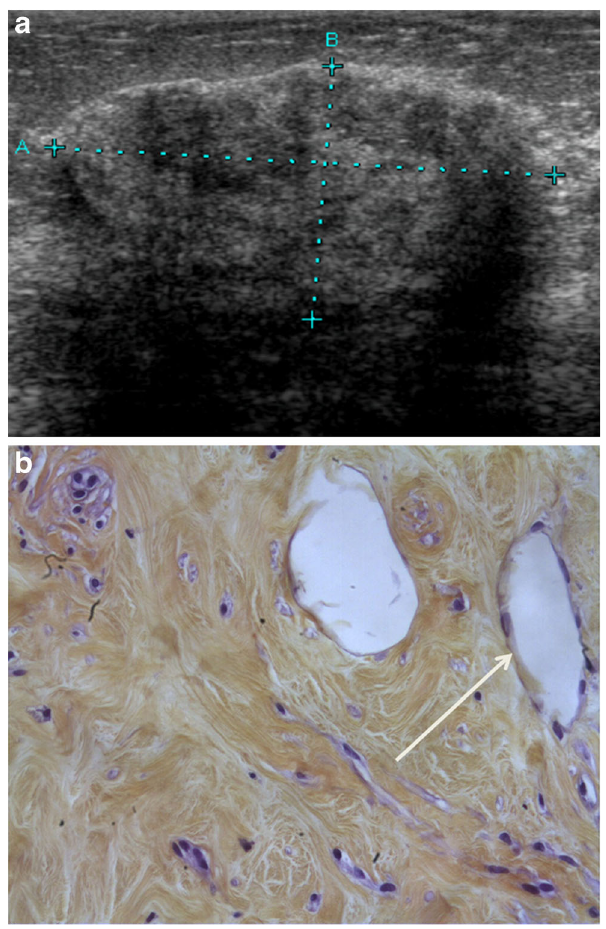
Fig. 9 PASH. a Ultrasound scan showing a hyperechoic, slightly heterogeneous and attenuating oval-shaped mass. b Microscopy (HES ×20): histological section showing fibrosis with pseudoangiomatous stromal hyperplasia ( arrow showing a channel lined by flat endothelium-like